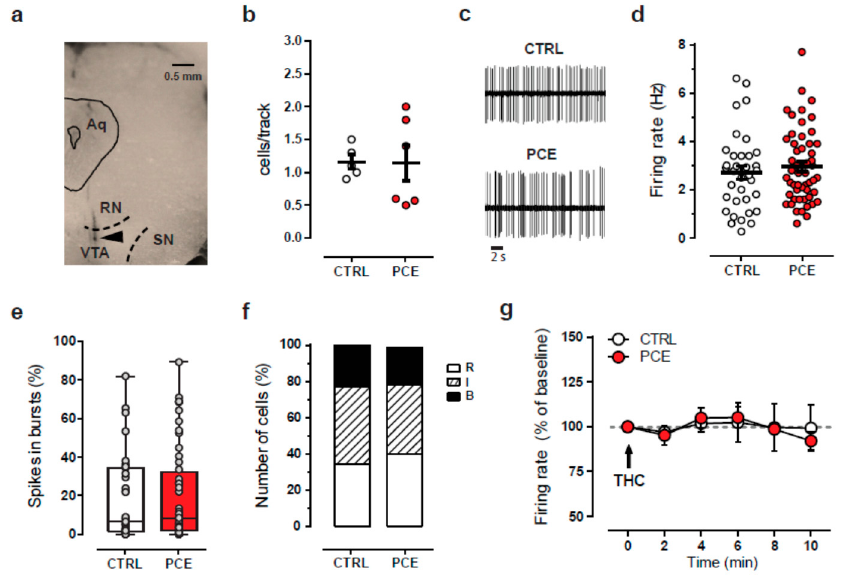
Figure 4. PCE effect on electrophysiological properties of putative dopamine neurons recorded in vivo from female preadolescent rats. ( a ) Coronal midbrain section from a preadolescent female rat showing the recording site (black triangle) in the ventral tegmental area. Abbreviations: Aq, aqueduct; RN, red nucleus; SN, substantia nigra, VTA, ventral tegmental area. ( b ) Scatter plot showing the average number of spontaneously active VTA dopamine neurons encountered per track. PCE ( n rats = 6) CTRL ( n rats = 5). ( c ) Representative traces of spontaneous firing activity of dopamine neurons from female offspring. ( d ) Spontaneous firing frequency of VTA dopamine cells from CTRL and PCE female rats. Data are represented as means s.e.m. with single values. ( e ) Percentage of spikes in burst displayed by dopamine neurons in female offspring. Data are represented as a box-and-whisker plot with single values, min to max. ( f ) The stack bars represent the percentage of dopamine cells displaying different firing patterns: R = regular; I = irregular; B = bursty. ( g ) Time course of the effect of acute THC (0.5 mg/kg, i.v) on the firing frequency of putative VTA dopamine neurons from PCE (n cells = 5) and CTRL (n cells = 5). Data represented as average ± s.e.m.